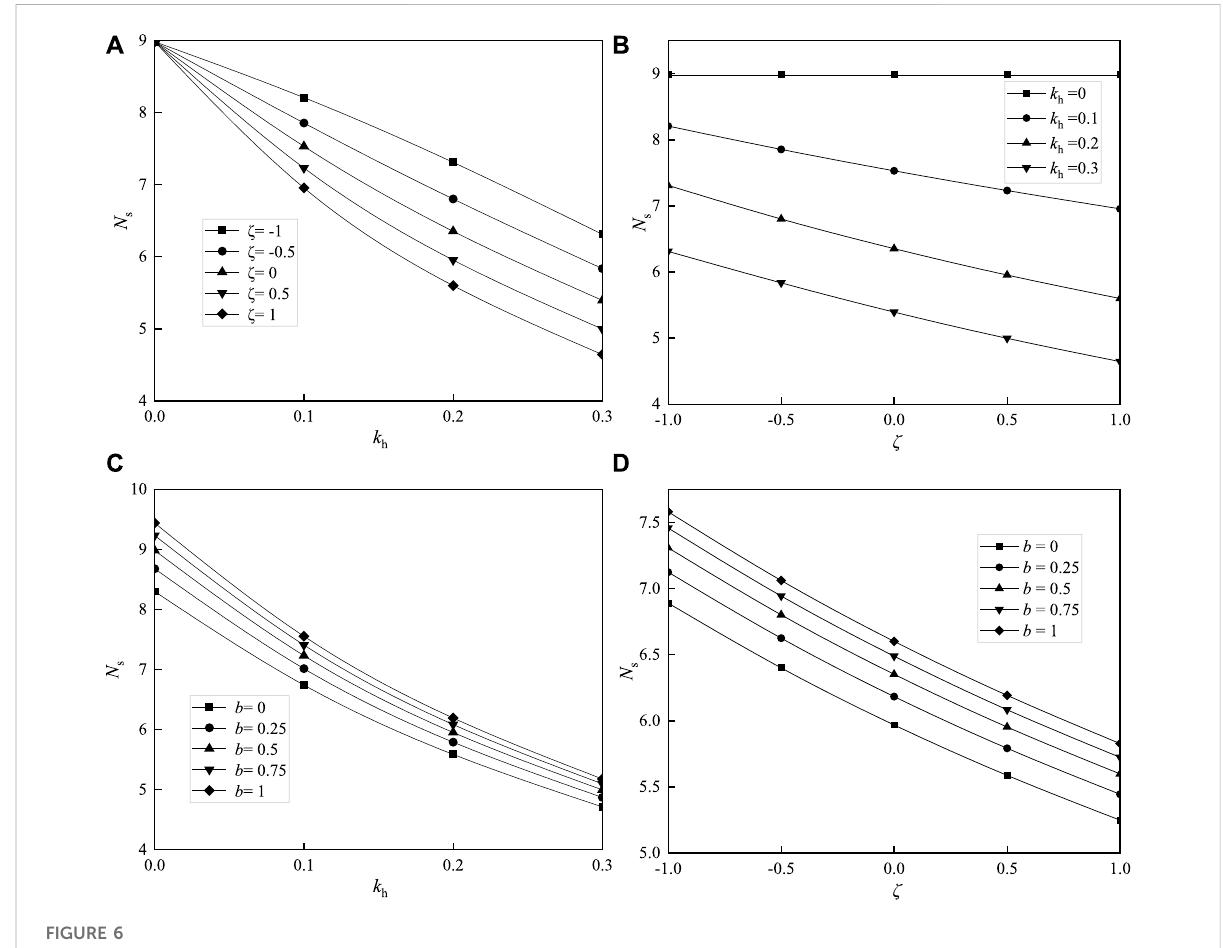
FIGURE 6 In fl uence of seismic force parameters on stability